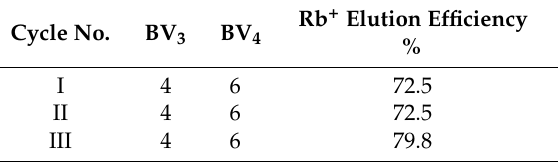
Table 9. Parameters for rubidium ion elution—PFC100x10.